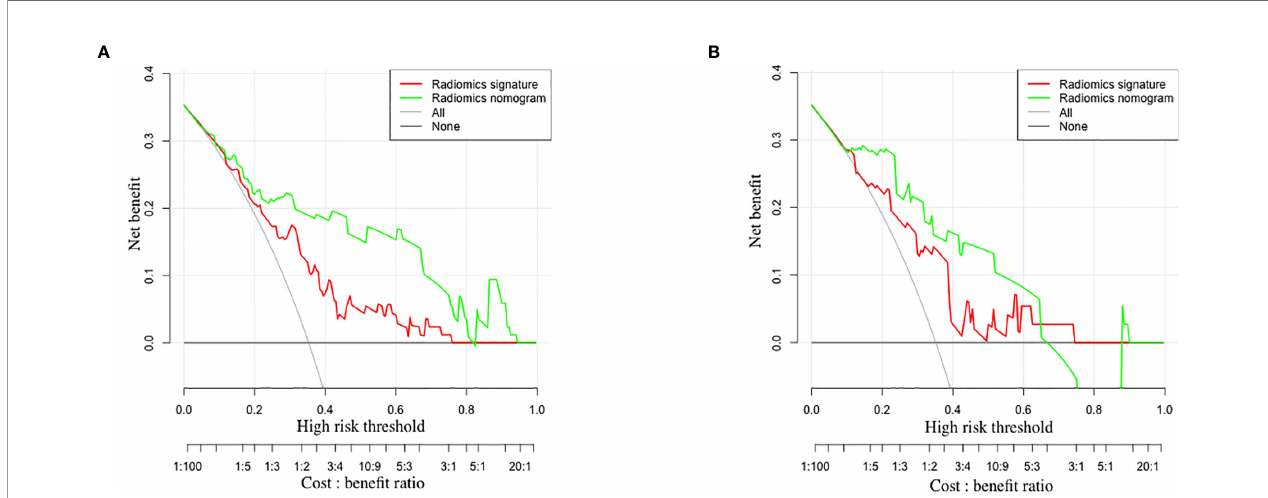
FIGURE 5 | The decision curves of radiomics signature and radiomics nomogram in the training set (A) and validation set (B) . The y-axis indicates the net bene fi t. The x-axis indicates the threshold probability at a range of 0.0 to 1.0. The red and green dotted lines represent the decision curves of radiomics signature and radiomics nomogram, respectively. The light gray line represents the decision curve of the assumption that all patients suffer from LN metastasis, and the dark gray line represents the decision curve of the assumption that no patients suffer from LN metastasis. The radiomics nomogram had higher net bene fi t than radiomics